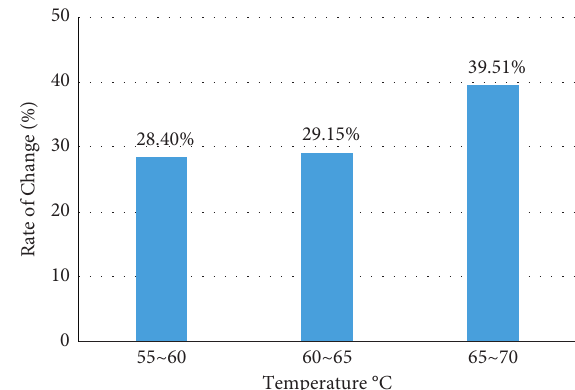
Figure 4: Percentage decrease in DS